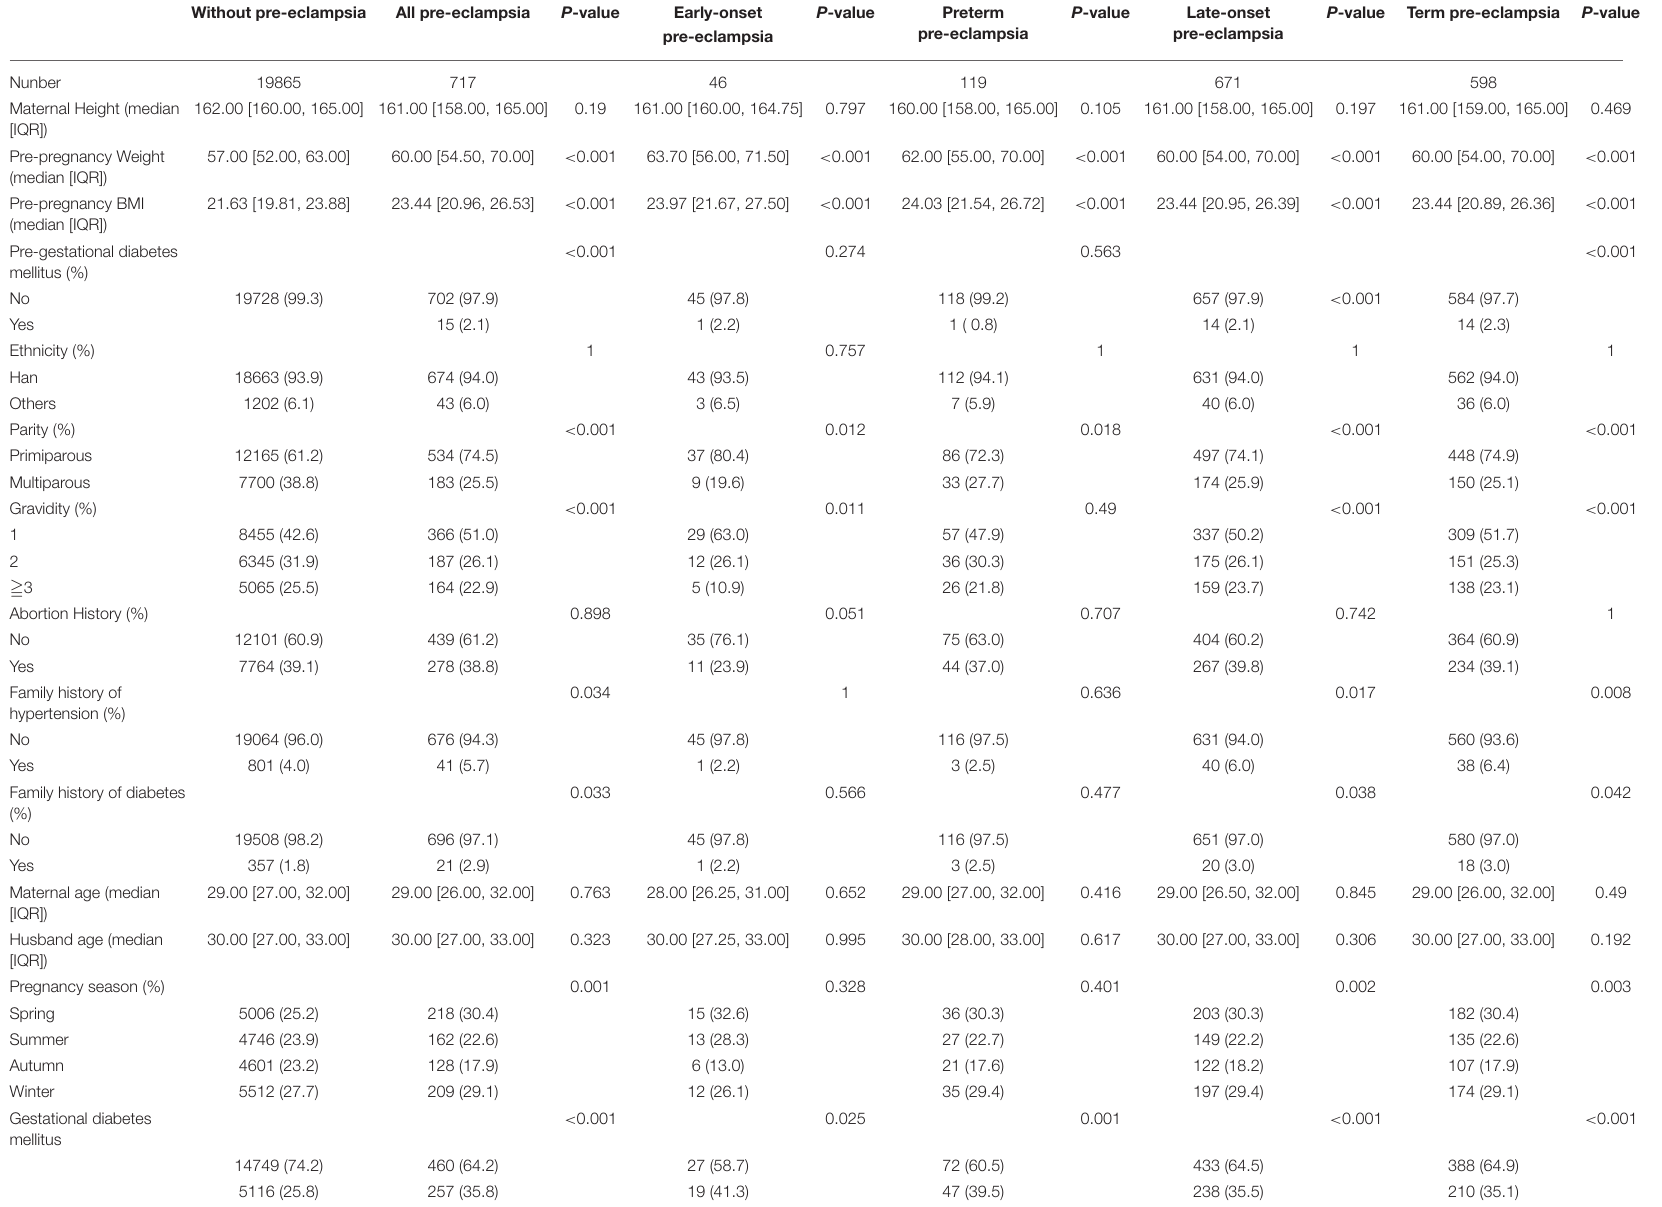
TABLE 1 | Characteristics of pregnancies in imputed